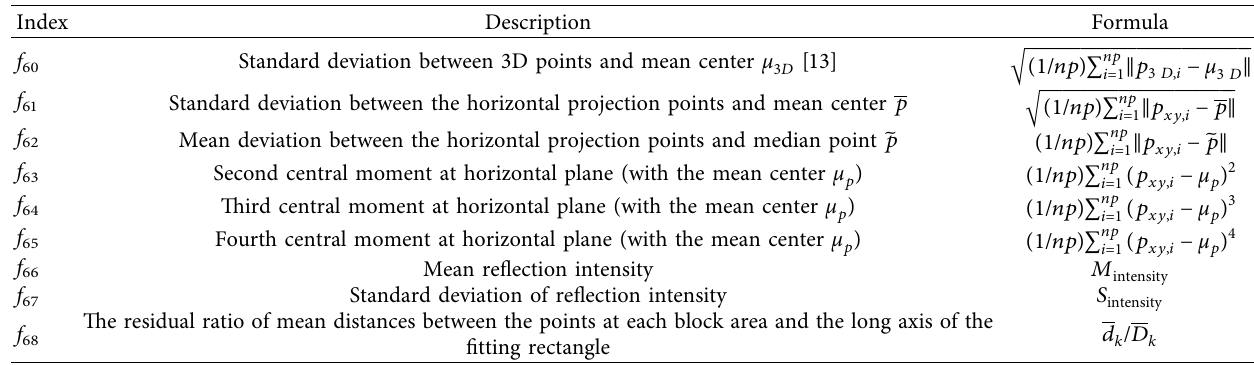
Table 3: Statistical